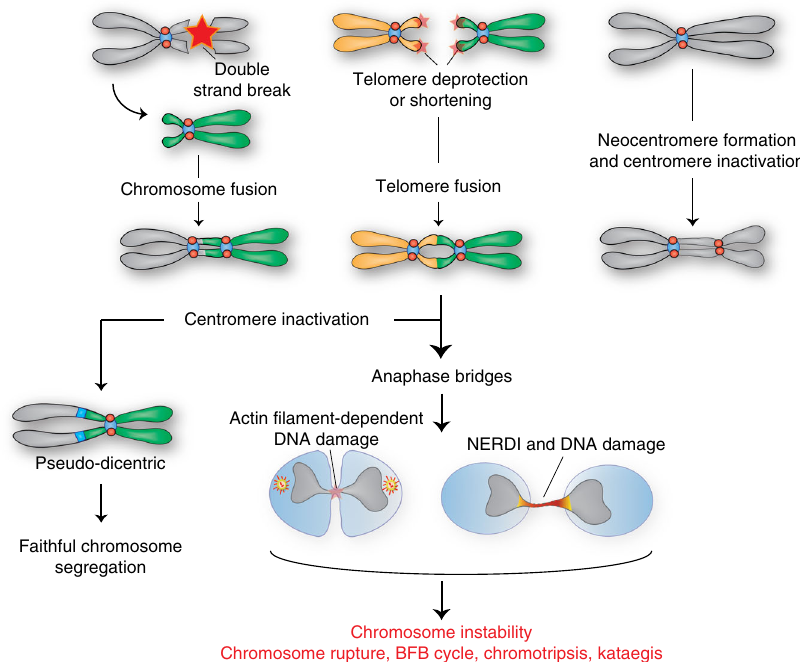
Fig. 4 Dicentric chromosomes and chromosome instability. Representation of the possible origins of dicentric chromosomes that arise from chromosome/ telomere fusions or neocentromere formation in the presence of a functional original centromere. During anaphase onset, the dicentric chromosome that is attached by opposing mitotic spindle fi bers is trapped, leading to anaphase and chromosome bridges and, consequently, DNA damage and chromosome instability. Centromere inactivation could restore faithful segregation by preventing incorrect spindle